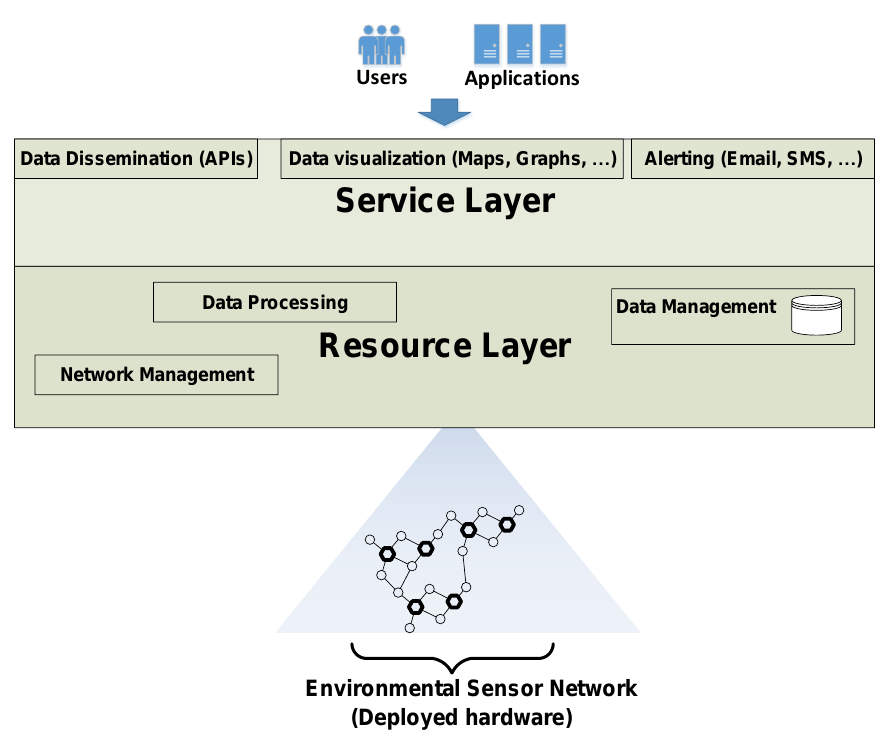
Figure 4. The IDEA Environmental Measurement Cloud, the context where our sensor was tested, is divided in two layers: a Service Layer and a Resource Layer . The Service Layer is the front-end to the environmental network’s users and third party applications while the Resource Layer manages the network’s hardware and data